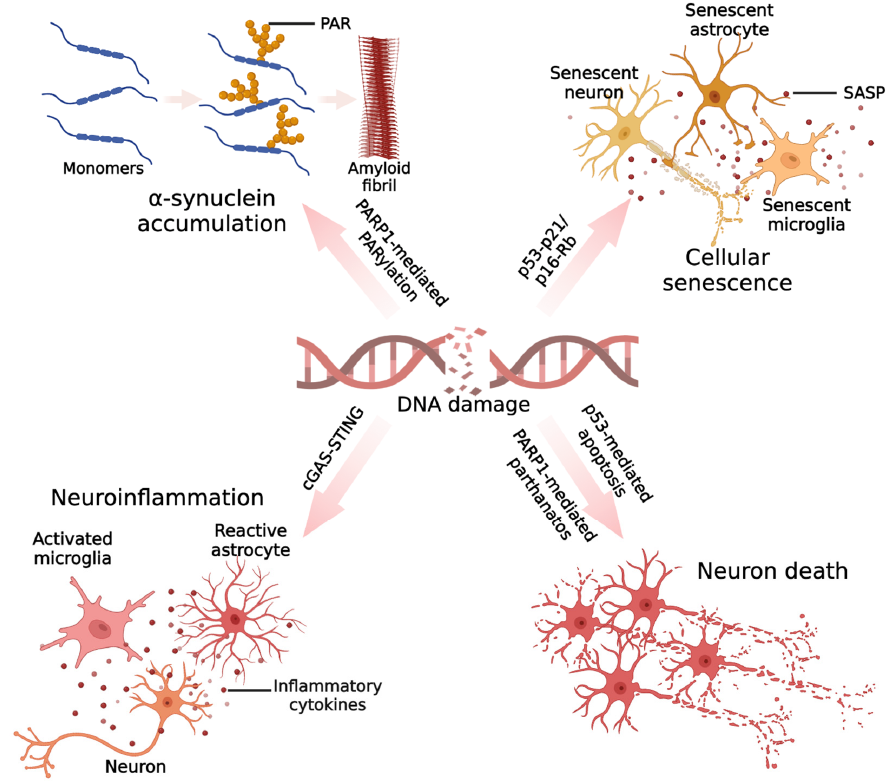
Figure 2. Mechanisms by which DNA damage could promote neurodegeneration in PD. In PD, the accumulated DNA damage leads to excessive activation of PARP1, and activated PARP1 can synthesize a large number of PAR chains. PAR is able to interact with the N-terminal portion of α -synuclein and promotes the fibrillation of α -synuclein monomers. Cellular senescence phenotypes have been reported in PD models, including senescent neurons, senescent microglia, and senescent astrocytes. In neurons, α -synuclein can induce DNA damage and upregulate the senescence markers p53 and p21. In microglia and astrocytes, pathogenic α -synuclein leads to the upregulation of P21 expression. In addition, the neurotoxin paraquat can cause astrocyte senescence phenotypes in vivo and in vitro, including DNA damage accumulation, p16 upregulation, and senescence-associated secretory phenotypes (SASPs). DNA damage has recently been found to induce inflammatory responses in several types of neuronal cells, including microglia, astrocytes, and neurons. The innate immune response induced by the cGAS–STING pathway plays a major role. Evidence for DNA damage-induced neuroinflammation in PD has been demonstrated in microglia. α -synuclein can attack the genomic DNA of microglia, which in turn activates the STING-dependent inflammatory response, leading to a massive release of inflammatory factors. The oxidative stress induced by inflammatory factors may further lead to DNA damage in other cells, contributing to the continued activation of the DNA damage response and causing a vicious cycle between DNA damage and inflammation. Lastly, DNA damage is thought to be an important cause of dopaminergic neuron death. Specifically, on one hand, DNA damage in PD models can activate a P53-dependent apoptotic program, and on the other hand, persistent DNA damage-induced hyperactivation of PARP1 can trigger parthanatos in neurons. (Created with